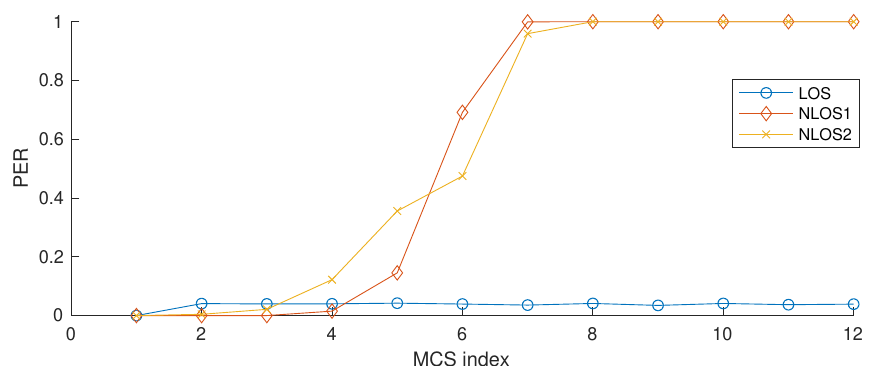
Figure 8. Measured packet error rate as a function of modulation and coding scheme index for the different measurement